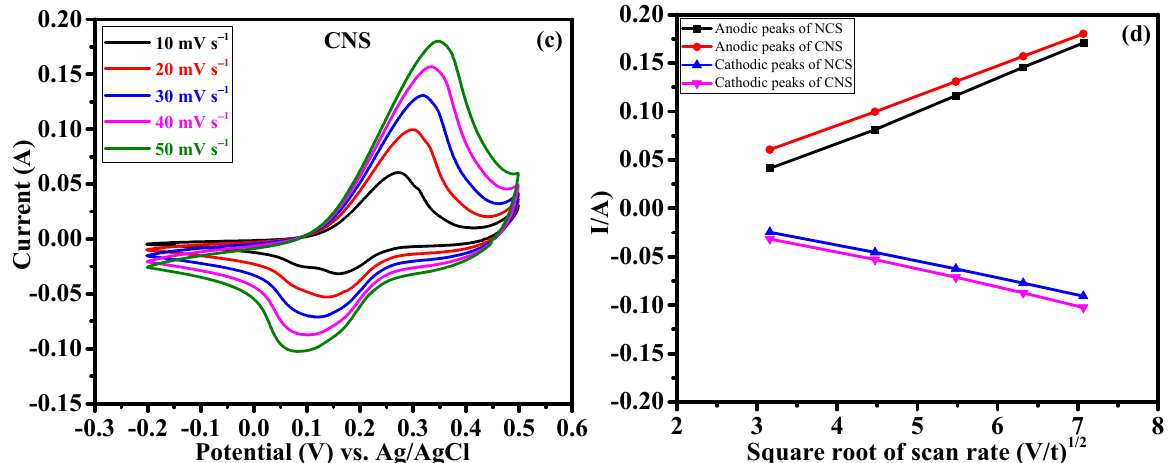
Figure 6. Cyclic voltammetry performance of NCS and CNS electrodes. ( a ) comparative CV curves, ( b , c ) detailed CV curves of NCS and CNS electrodes at different sweep rates, respectively. ( d ) The relationship between the cathodic/anodic peak current and the square root of the scan rate for NCS and CNS electrodes.